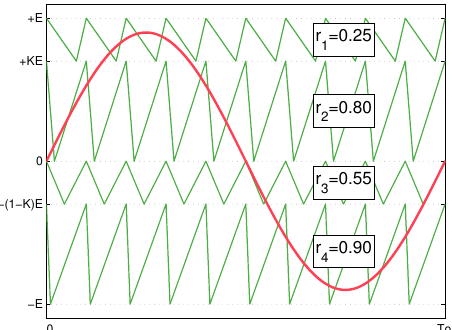
Figure 3. Five-level PD-SPWM with modified carrier slopes: Note that the carrier ratios do not represent standard carriers. Each carrier controls one switching zone as follows: r 1 [+ E , + KE ] , r 2 [+ KE ,0 ] , ( 1 ( 1 r 3 [ 0, K ) E ] , and r 4 [ K ) E , E ] − − − − −